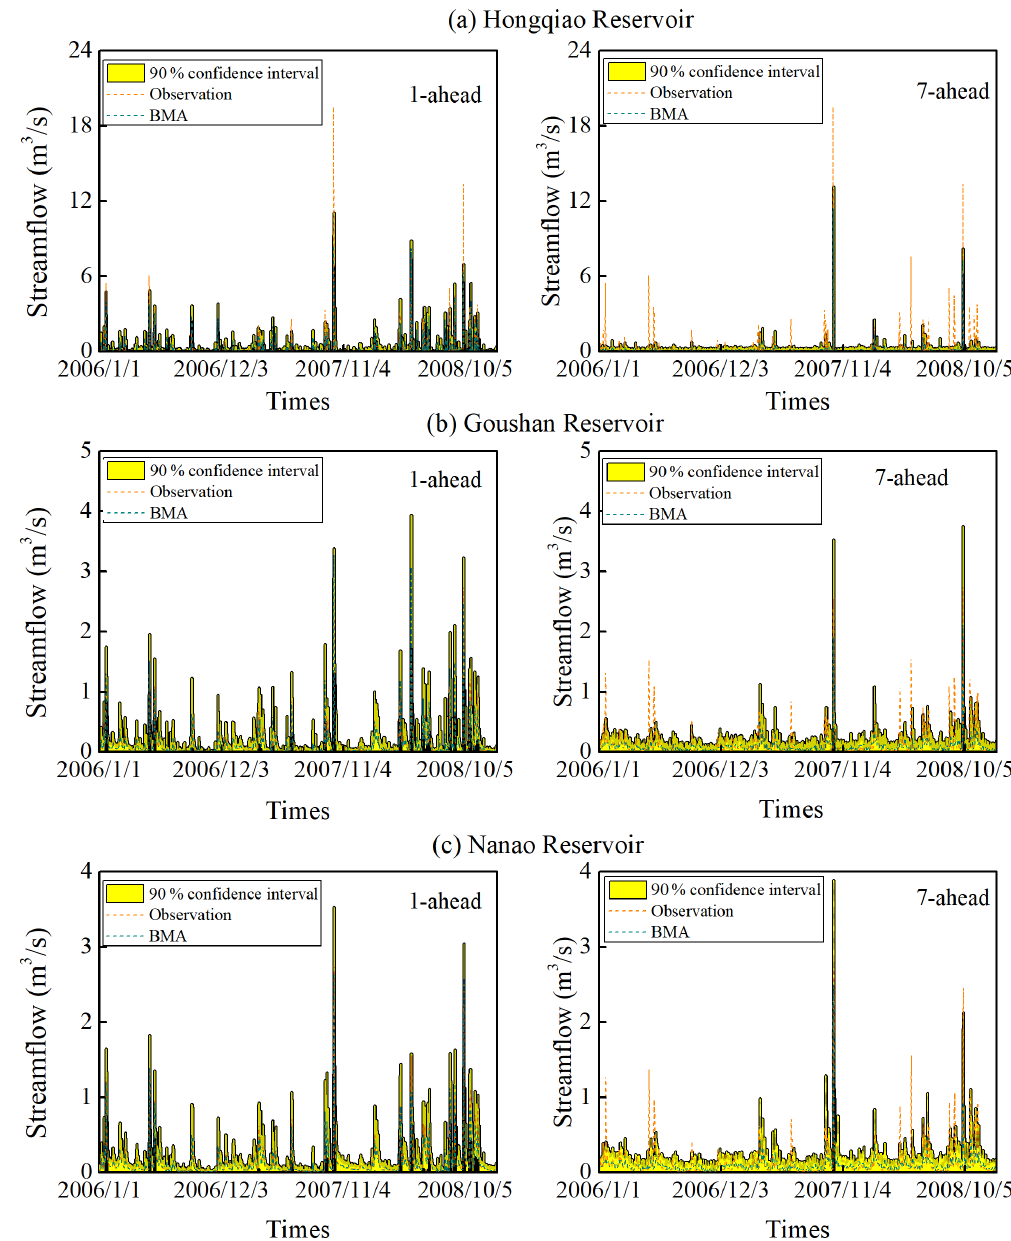
Figure 12. The 90% streamflow interval of the BMA method under